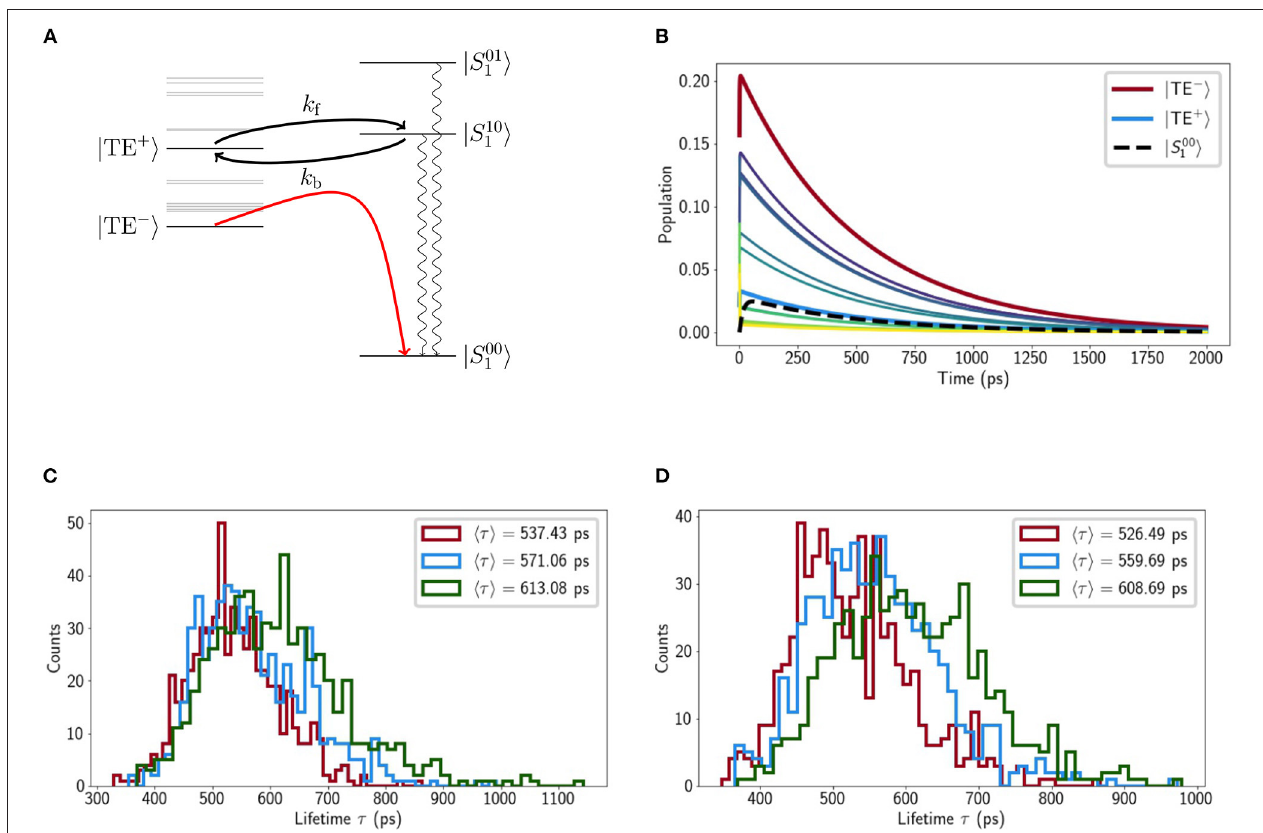
FIGURE 4 | (A) Schematic representation of our model with the Chl excitonic manifold shown on the left and relevant carotenoid vibronic states on the right (energies are to scale). (B) Chl exciton populations calculated from the crystal structure as a function of time. The exciton states associated with the terminal emitter along with the population on lowest vibrational level of S 1 ( and neutral pH (D) ,